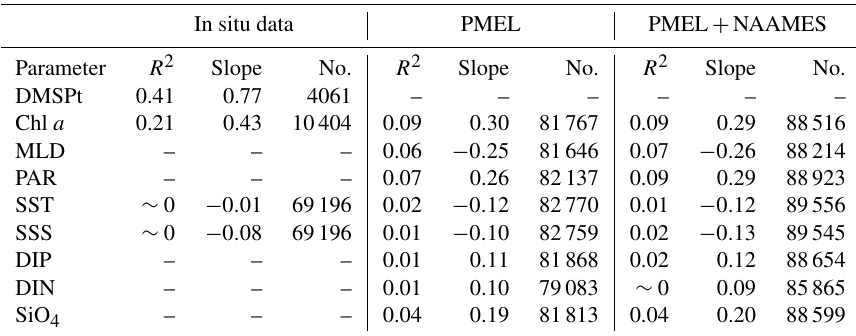
Table 1. Results of linear regression models. The R 2 values are for log-transformed and normalized data as described in the text. In situ data PMEL PMEL + NAAMES Parameter R 2 Slope No. R 2 Slope No. R 2 Slope No. DMSPt 0.41 0.77 4061 Chl a 0.21